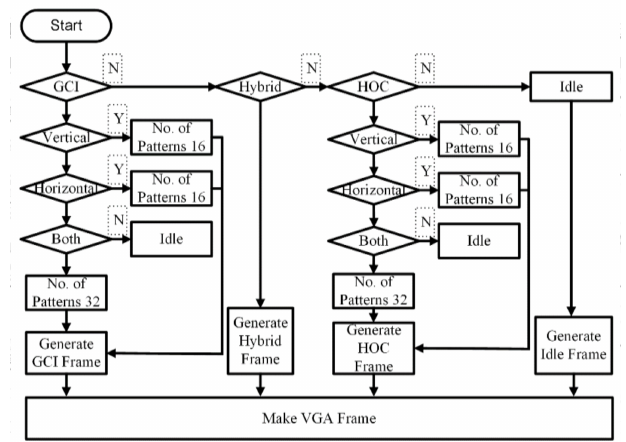
Figure 4. Internal flow diagram of the pattern selection module and selection of a procedure for patterns